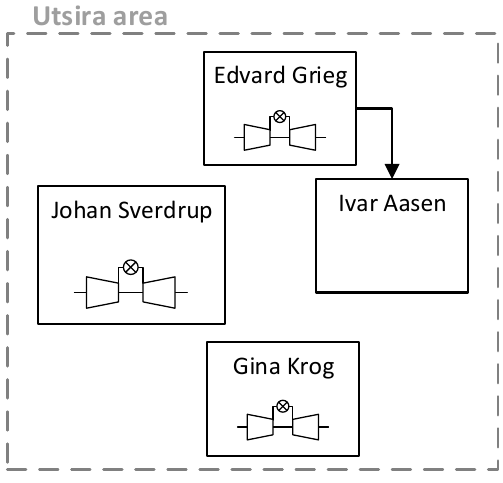
Figure 3. Scheme of Concept 0 —Gas turbine cycles.